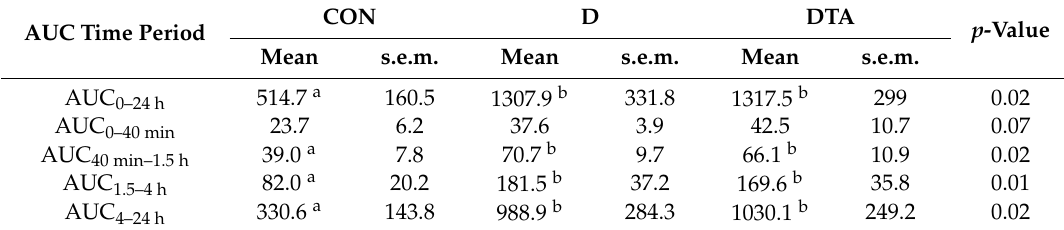
Table 2. Area under the curve (AUC) (nmol / L per ha ± s.e.m.) for the plasma cortisol of calves subjected to sham dehorning (CON), dehorning (D), or dehorning with an application of topical anaesthetic (DTA). AUC 0–24 = area under curve from pre-treatment to 24 h post-treatment; AUC 0–40 min = area under the curve from pre-treatment to 40 min post-treatment; AUC 40 min–1.5 h = area under the curve from 40 min to 1.5 h post-treatment; AUC 1.5–4 h = area under the curve from 1.5 h to 4 h post-treatment; AUC 4–24 h = area under the curve from 4 h to 24 h post-treatment. Within a row, means without a common superscript di ff er significantly ( p <